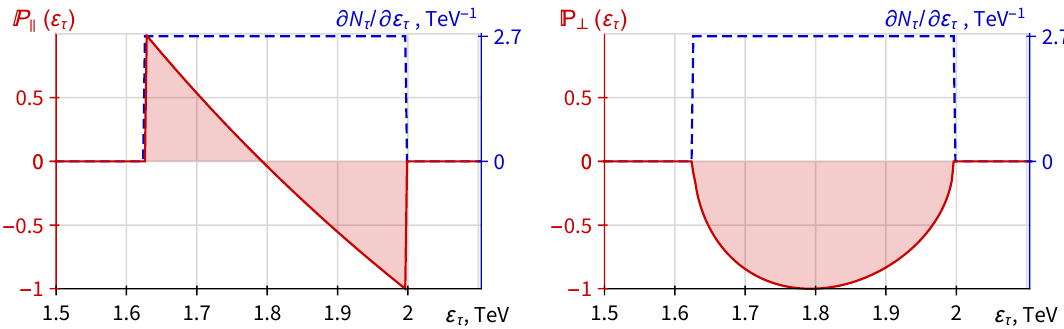
Figure 2 . (Left) Longitudinal and (right) transverse polarisations as a function of the energy of (cid:28) leptons produced by 2 TeV D s mesons. The red solid line is the polarisation and the blue dashed line is the (cid:28)